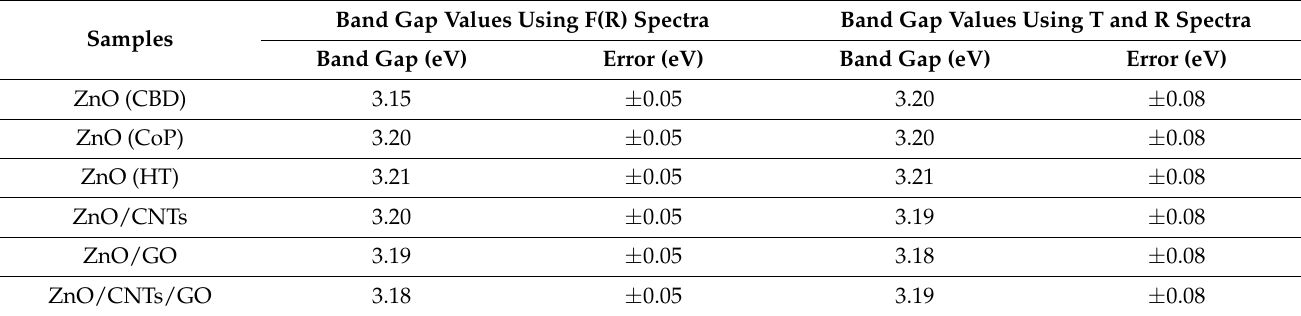
Table 2. Band gaps for the ZnO nanostructures and carbon/ZnO nanocomposites.